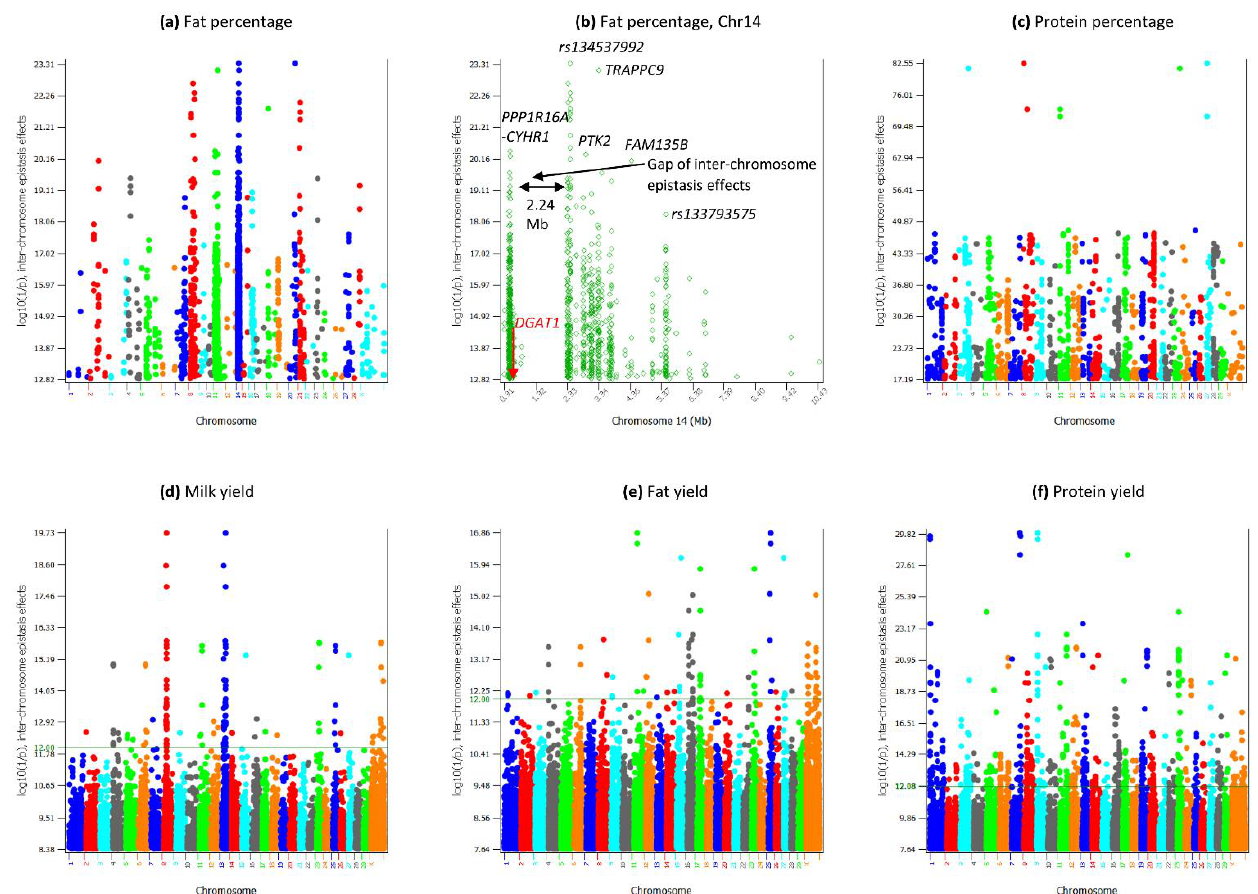
Figure 2. Manhattan plots of statistical significance of inter-chromosome epistasis effects for milk production traits. ( a ): Fat percentage. ( b ): Inter-chromosome epistasis effects of the 0.3-10.5 Mb region of Chr14 for fat percentage. ( c ): Protein percentage. ( d ): Milk yield. ( e ): Fat yield. ( f ): Protein yield.